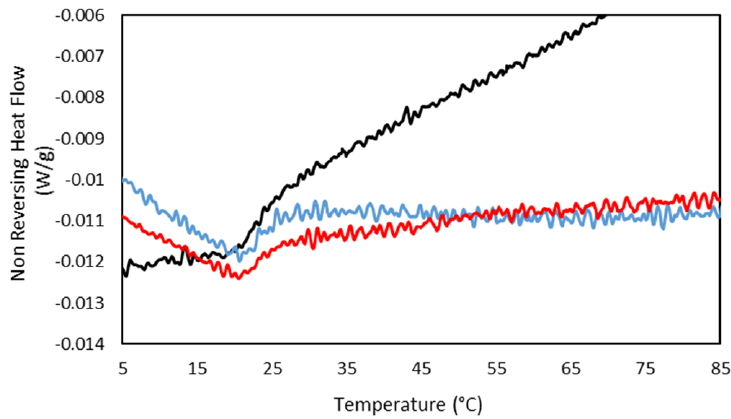
Figure 11. MDSC thermograms of the Non Reversing Heating scan of ( - ) 25GE, ( - ) 25GE/DOX and ( - ) 25GE/Crocin at 0.5 °C·min − 1 .